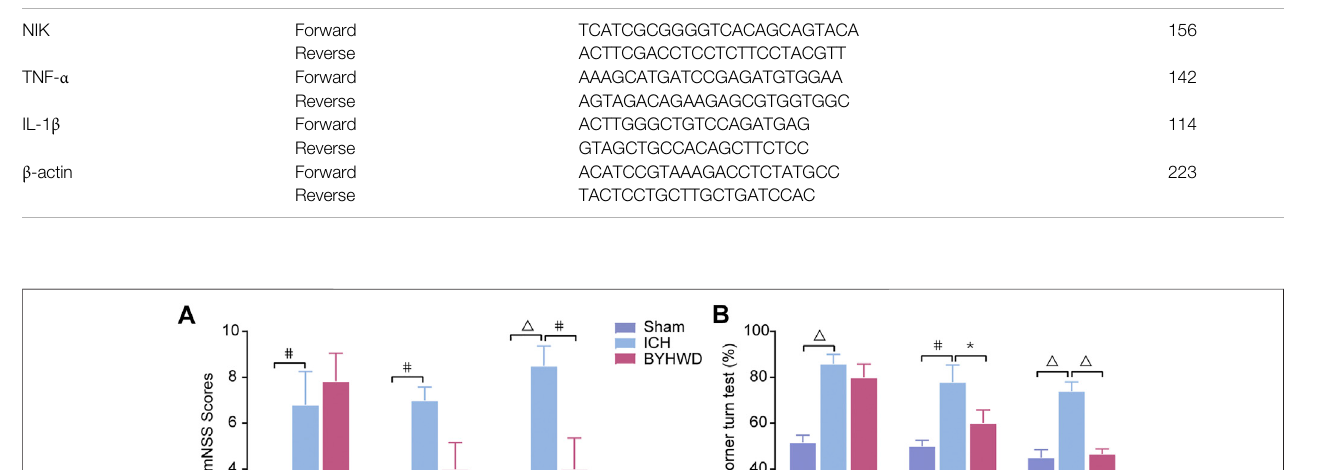
TABLE 2 | The RT-qPCR sequences of primers. Gene